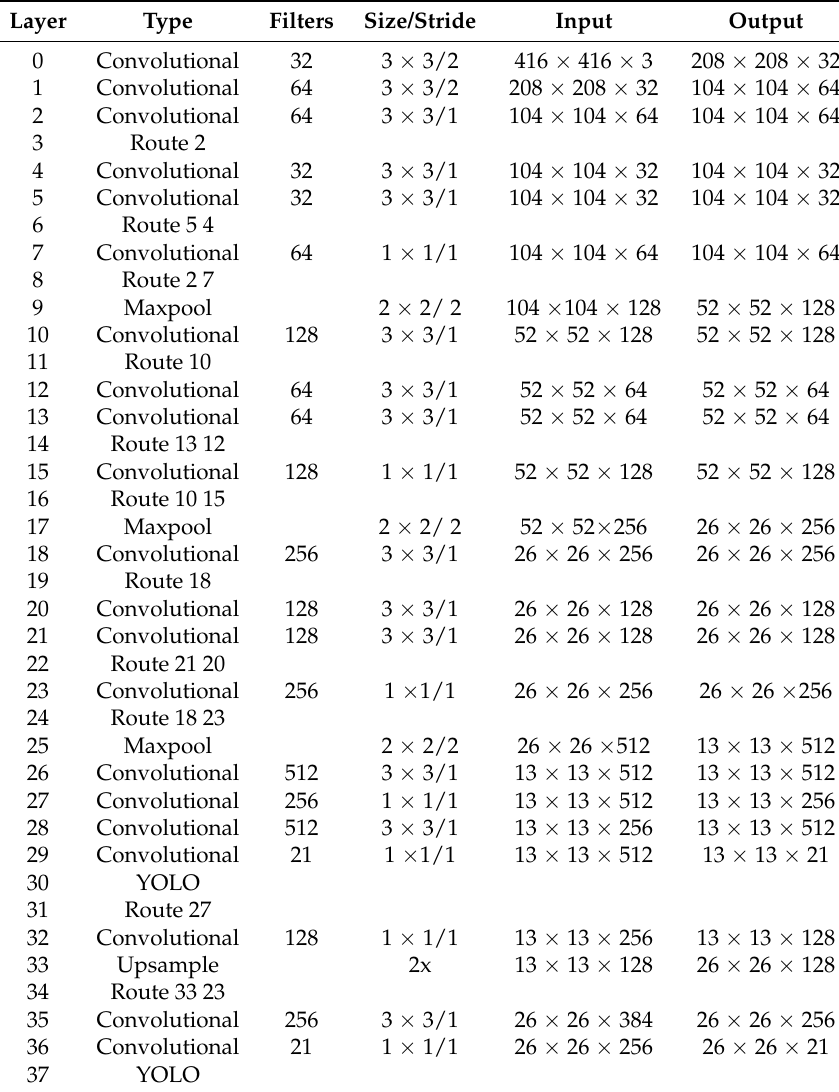
Table 4. Network structure of